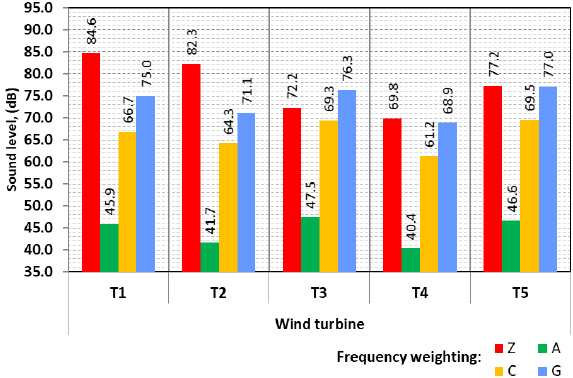
Figure 9. Comparison of the values of equivalent noise levels of investigated turbines for various weighting curves as well as excluding weighting.